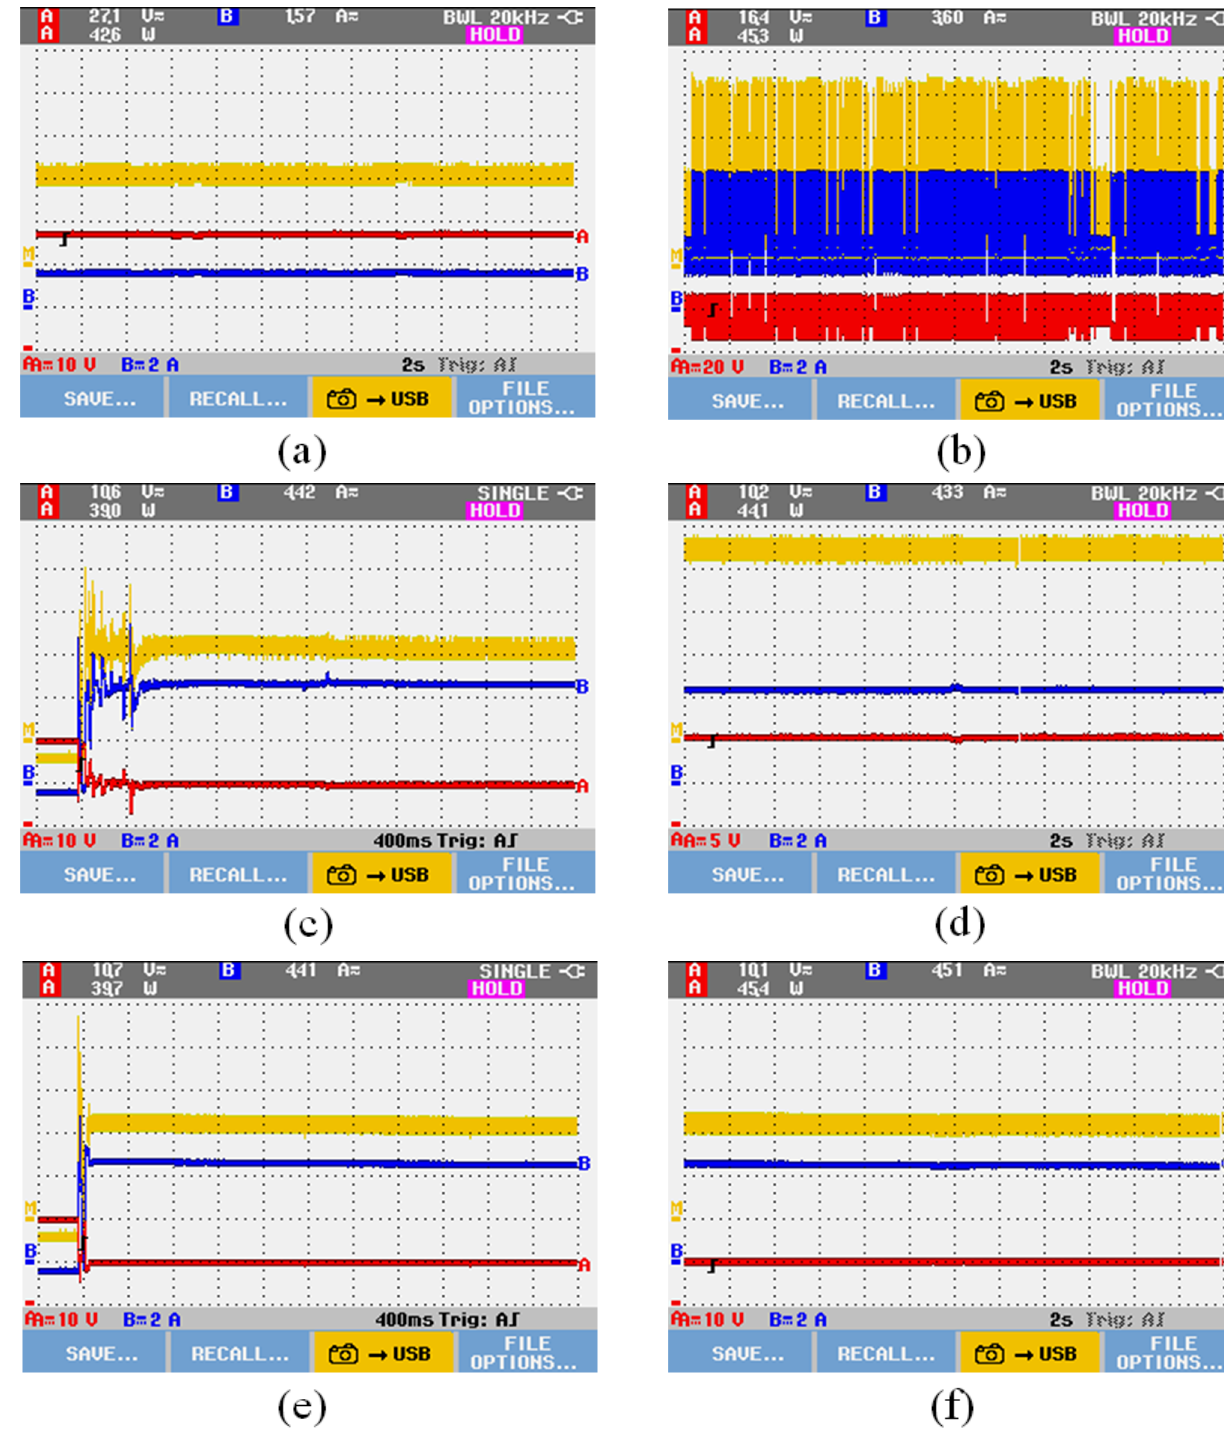
Figure 14. The convergence waveform in the practical experiment under (PSC): ( a ) the P&O method with a step size of 0.0001, ( b ) the P&O method with a step size of 0.1, ( c ) the transient waveform of the CSA method, ( d ) the steady-state waveform of the CSA method, ( e ) the transient waveform of the ICSA method, and ( f ) the steady-state waveform of the ICSA method.